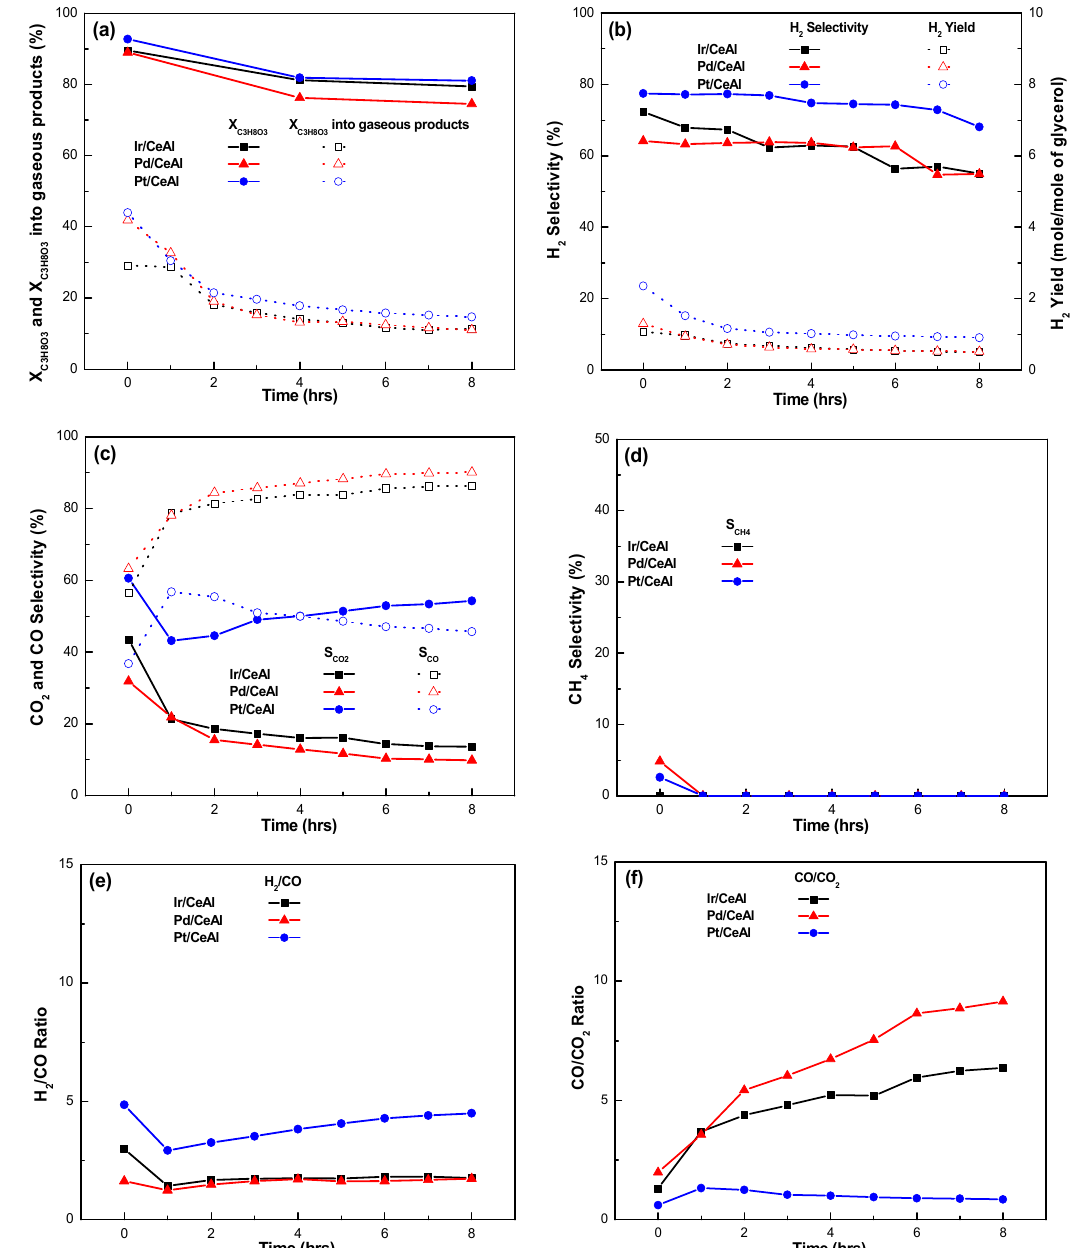
Figure 10. Time-on-stream experiments for all catalysts: ( a ) Total C 3 H 8 O 3 conversion and C 3 H 8 O 3 conversion into gaseous products, ( b ) H 2 selectivity and yield, ( c ) CO 2 , CO selectivity (y-axis on a di ff erent scale), ( d ) CH 4 selectivity (y-axis on a di ff erent scale), ( e ) H 2 / CO molar ratio, ( f ) CO / CO 2 molar ratio.